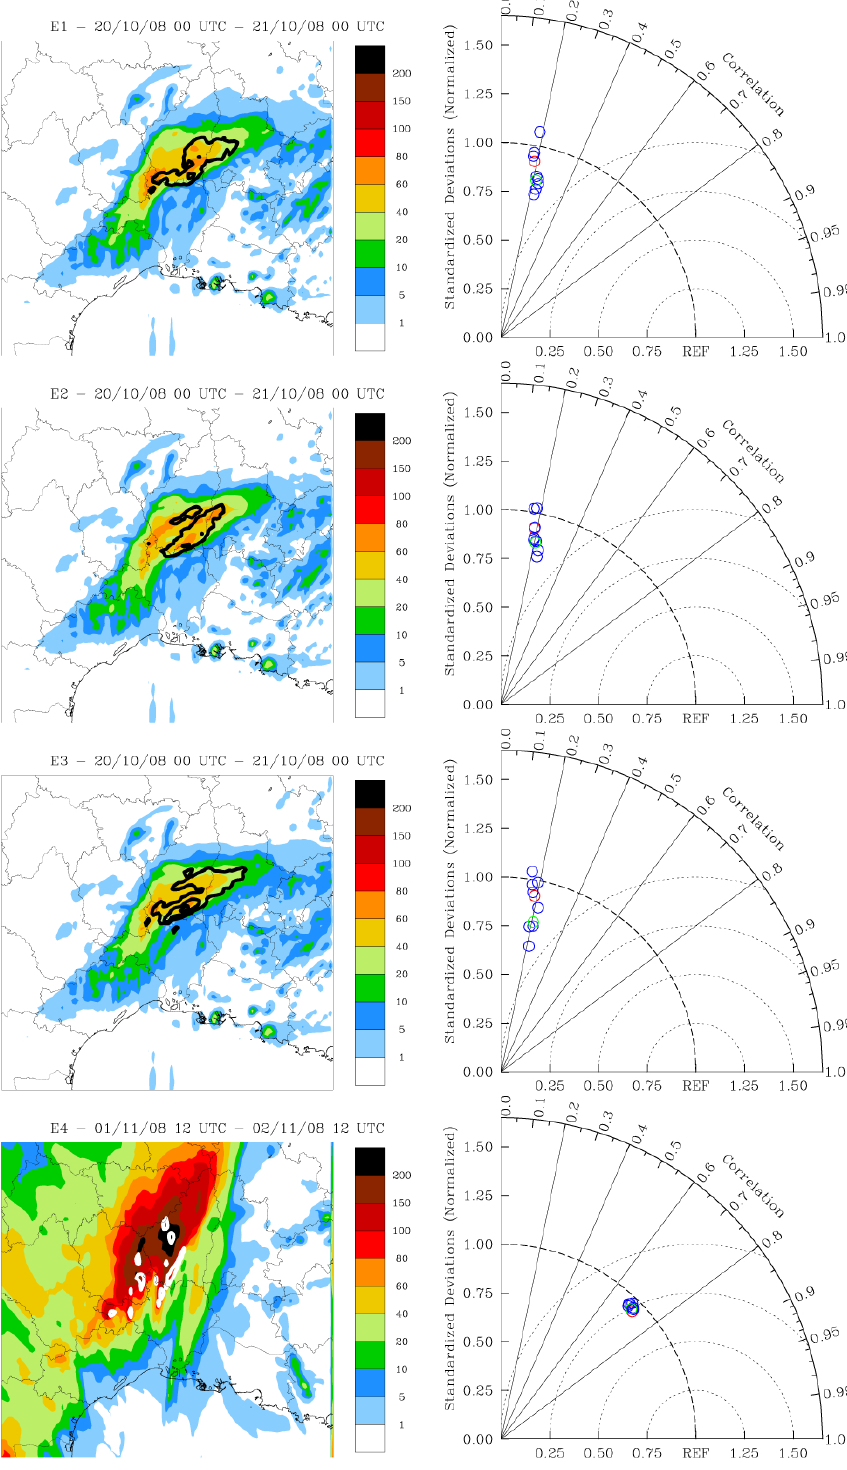
Fig. 10. 24-h accumulated precipitation ensemble statistics for E1, E2, E3 (Gard-H´erault case) and E4 (C´evennes case). Standard deviation (contour every 20mm starting at 20mm) superimposed on the ensemble mean (left) and Taylor diagrams (right). On the Taylor diagrams, individual members appear in blue, the reference run in red, and the ensemble mean in